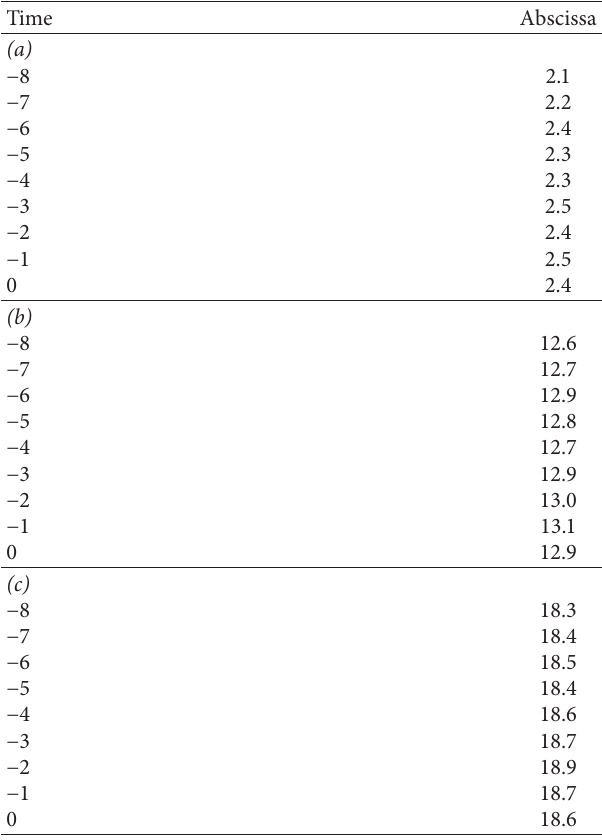
Table 2: Data coordinates measured in the experiment.